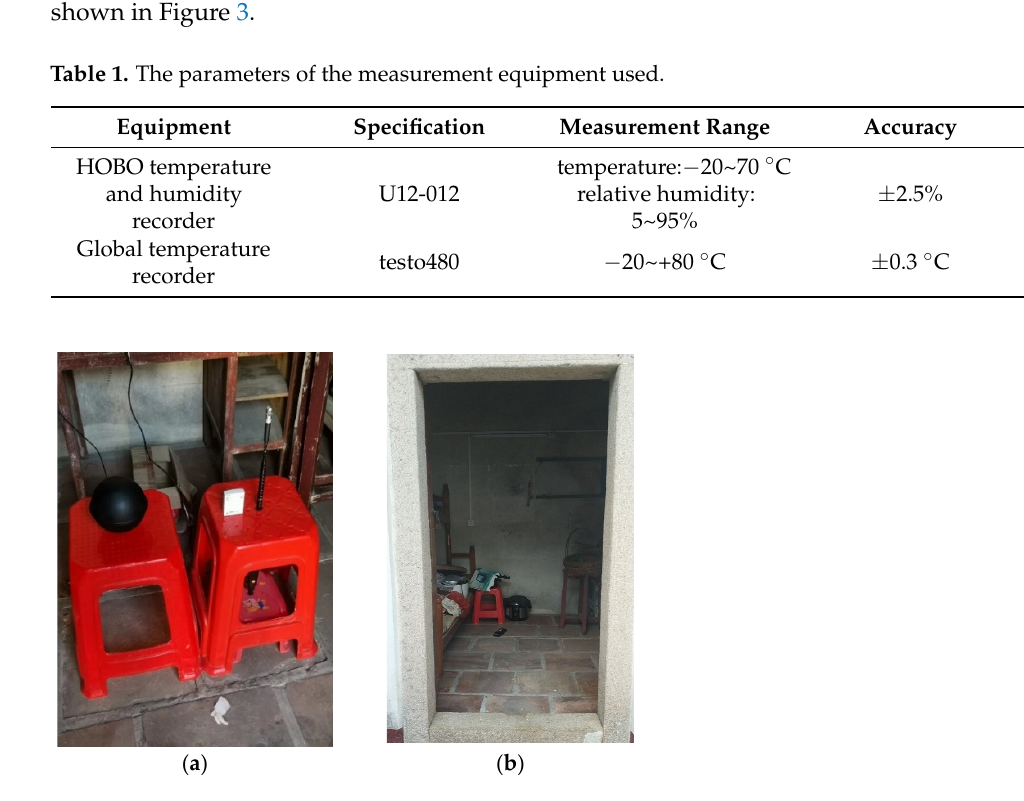
Figure 3. Instruments and their layouts: ( a ) Hall; ( b ) Utility